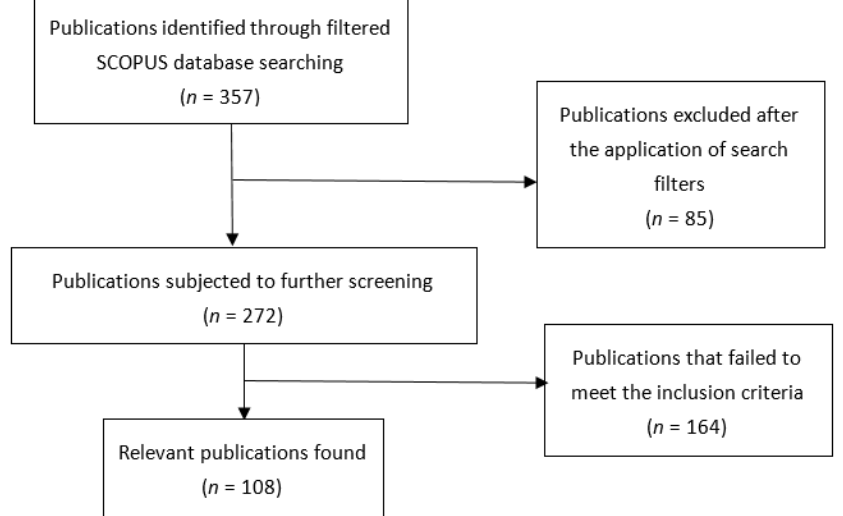
Figure 1. Flow chart of the screening process.